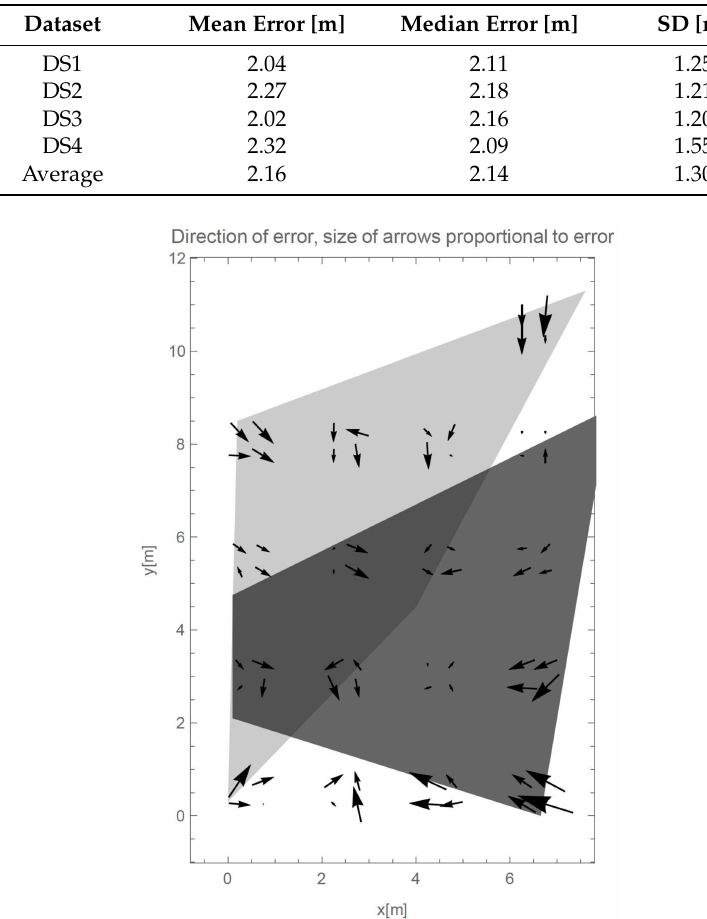
Figure 5. Directions and proportional size of errors for the localization of all four datasets. Light polygon’s vertices show positions of the Wi-Fi APs, dark polygon marks HomeMatic